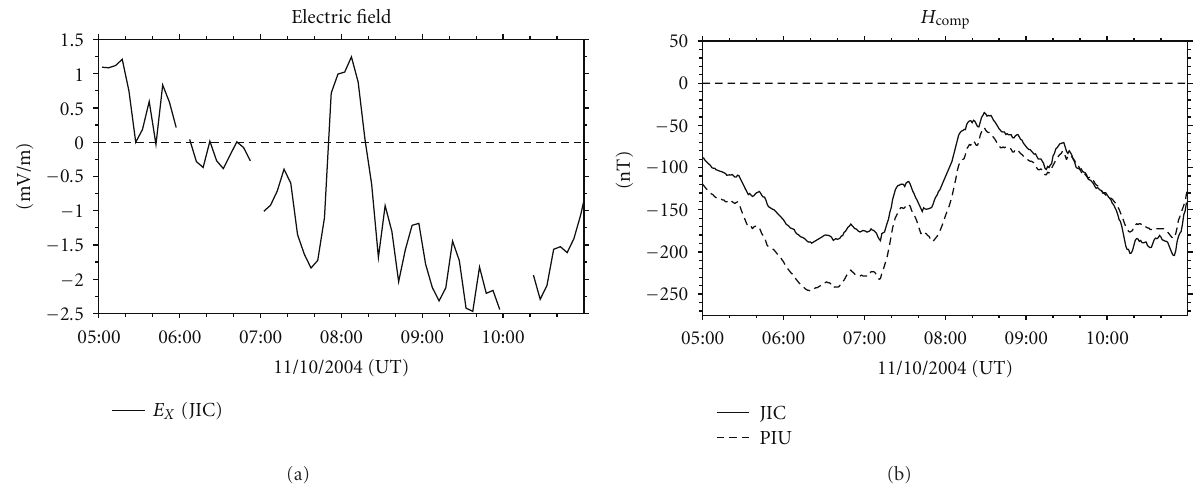
Figure 3: The eastward electric field at Jicamarca for a 6hr period on 10 November 2004. (b) shows the horizontal magnetic field on (Jicamarca) and o ff (Piura) the equator.